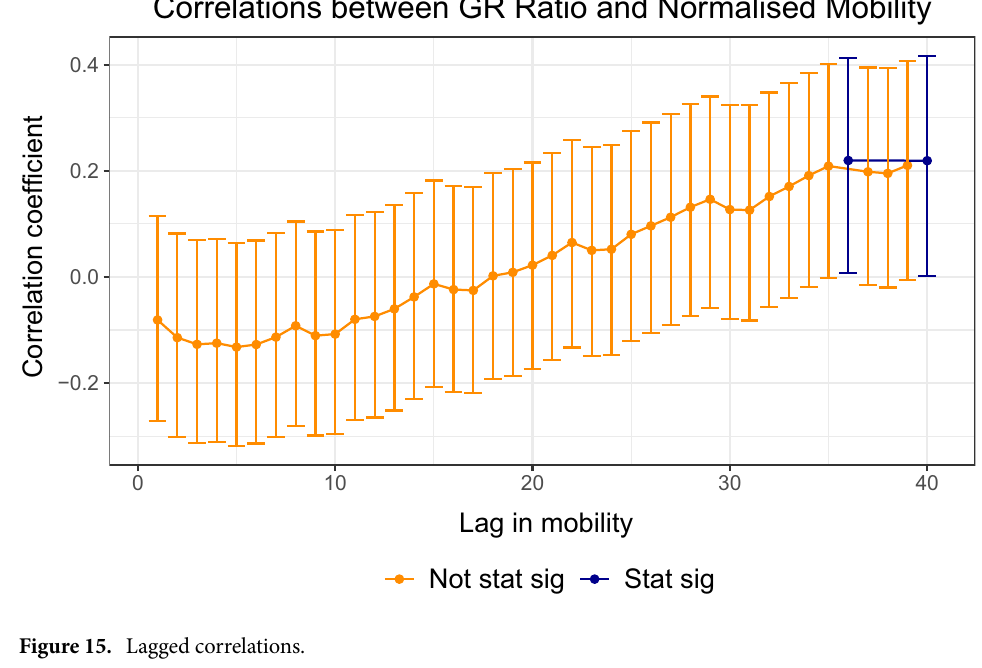
Figure 15. Lagged correlations.